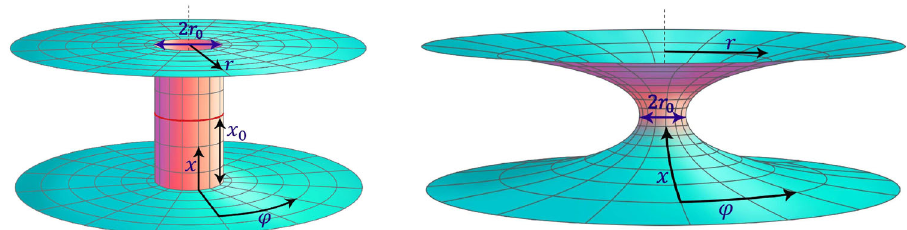
Fig. 1 Schematic demonstration of a wormhole with sharp transition (on the left) and the Ellis wormhole (on the